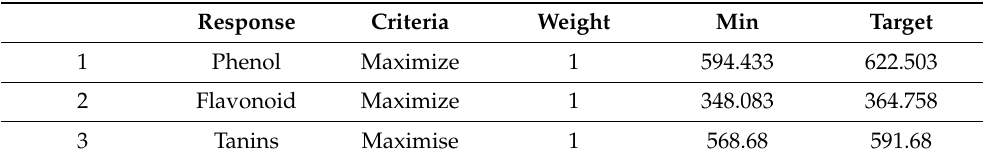
Table 2. Presentation of the optimisation routine of MODDE 5.0 used for maximising the phenolic compound yield of the three compounds